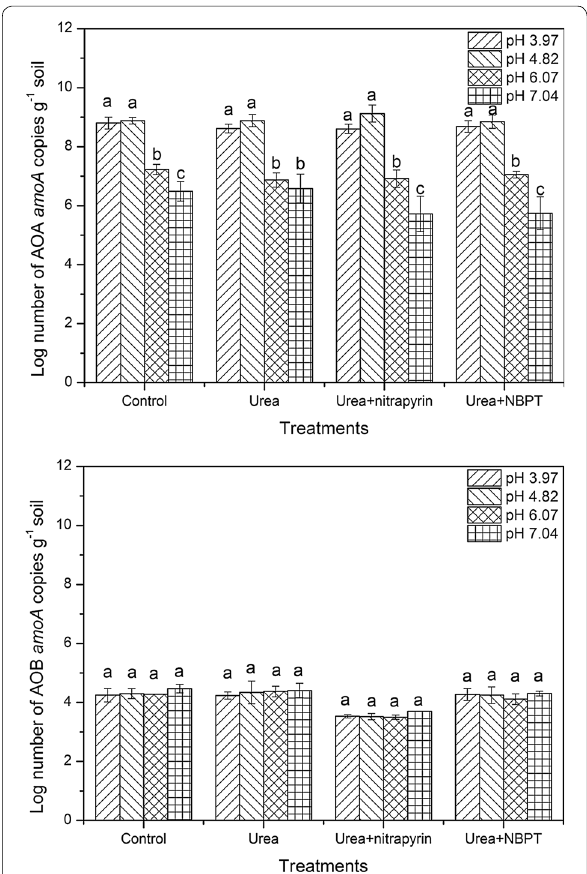
Fig. 3 Log number of AOA and AOB amoA copies in four different treatments (control; urea; urea nitrapyrin; urea NBPT) at different + + pH levels. Error bars indicate standard errors of three replicates, dif- ferent small letters indicate the significant difference within the same treatment at different pH levels ( P <